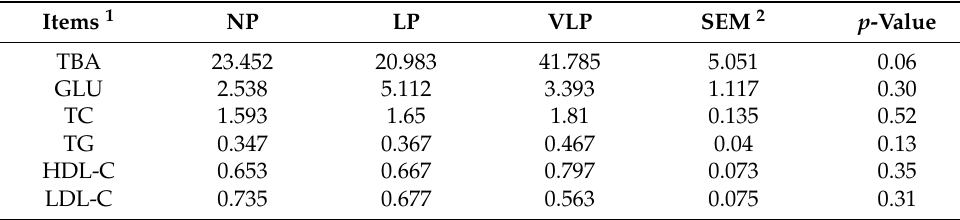
Table 2. Effect of Low-protein Diet on blood lipid profiles of Finishing Pigs.(mmol/L). Items